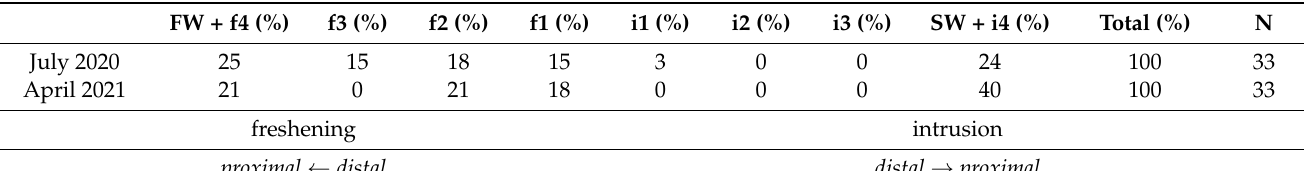
Figure 13. Representation of 33 samples collected in the rain season 2020 and dry seasons 2021 on the HFE-Diagram. Table 4. Distribution of sub-stages (in %) in freshening and intrusion phases for each sampling